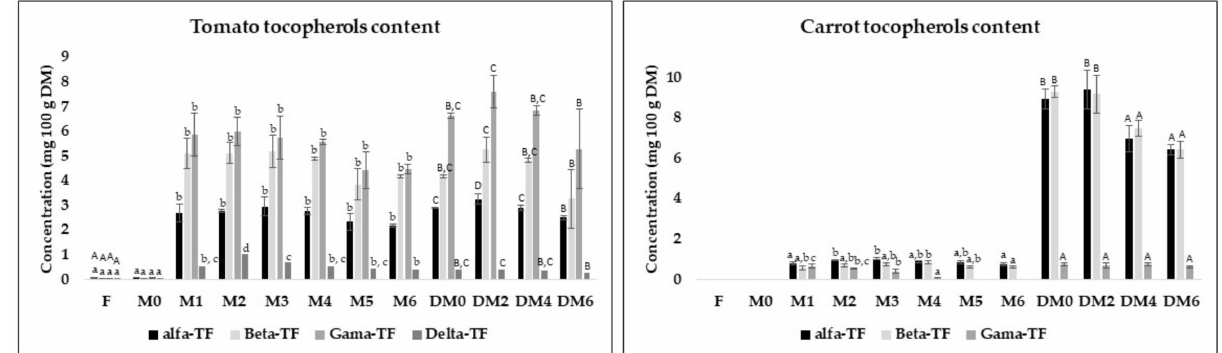
Figure 5. The concentration of α -tocopherol, β -tocopherol, γ -tocopherol and δ -tocopherol ( n = 3) detected in fresh carrot and tomato by-products and during the freezing and drying storage by HPLC-DAD. All results (mean ± standard deviation) were expressed in mg 100 g − 1 on a dry basis. Bars of the same color and corresponding to the same method of storage with different superscript letters are significantly different ( p < 0.05). Lowercase letters were used for fresh and frozen pulps forms while uppercase letters were used for fresh and dry powders forms. M0 = 24 h after the freezing storage of pulps. M1, M2, M3, M4, M5, M6 = month one, two, three, four, five and six of the freezing storage of pulps, respectively. DM0 = day 0 of the powders’ storage. DM2, DM4, DM6 = month two, four and six of the storage period of